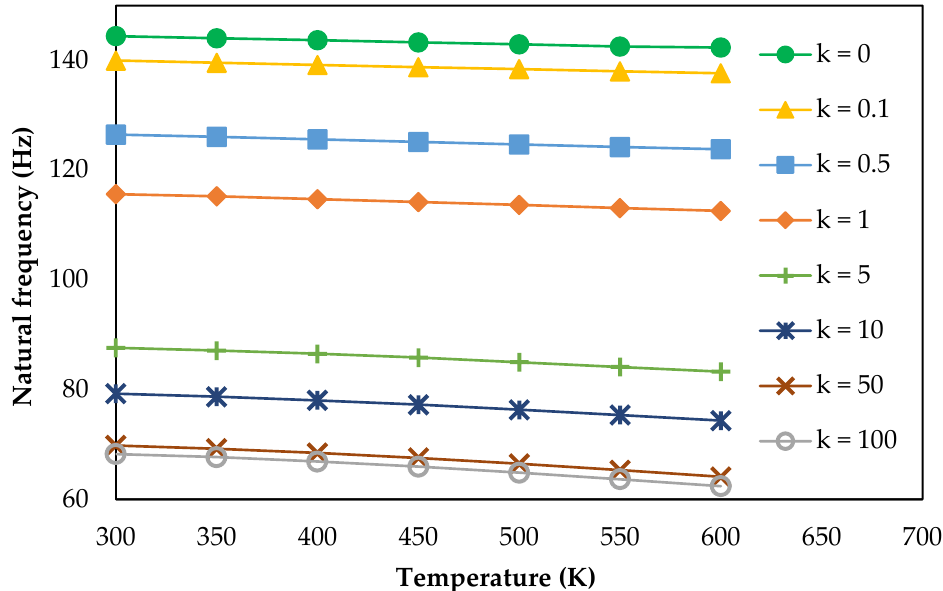
Figure 7. Variation of the natural frequency of an aluminum/silicon carbide FGM shell in a uniform thermal field for different material composition for re-entry vehicle nose structures.